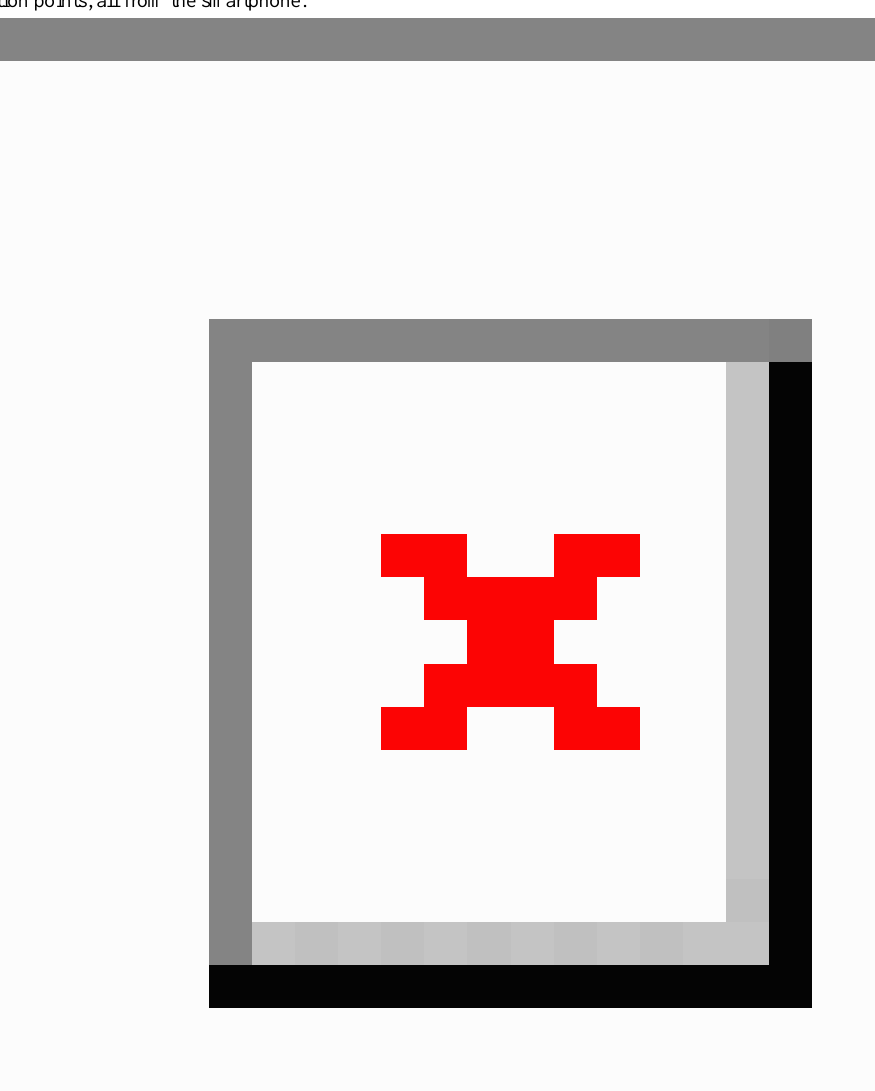
Figure 3. QuantiaMD allows for interactive case challenges within multiple specialties, features guest lecturers, and allows physicians to earn continuing medical education points, all from the